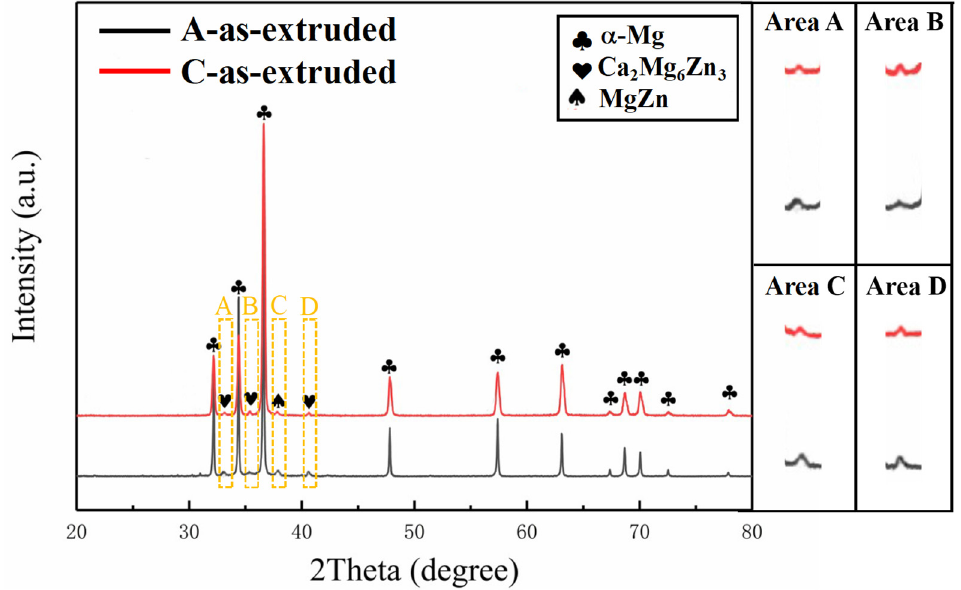
Figure 2. XRD profiles of A-as-extruded and C-as-extruded